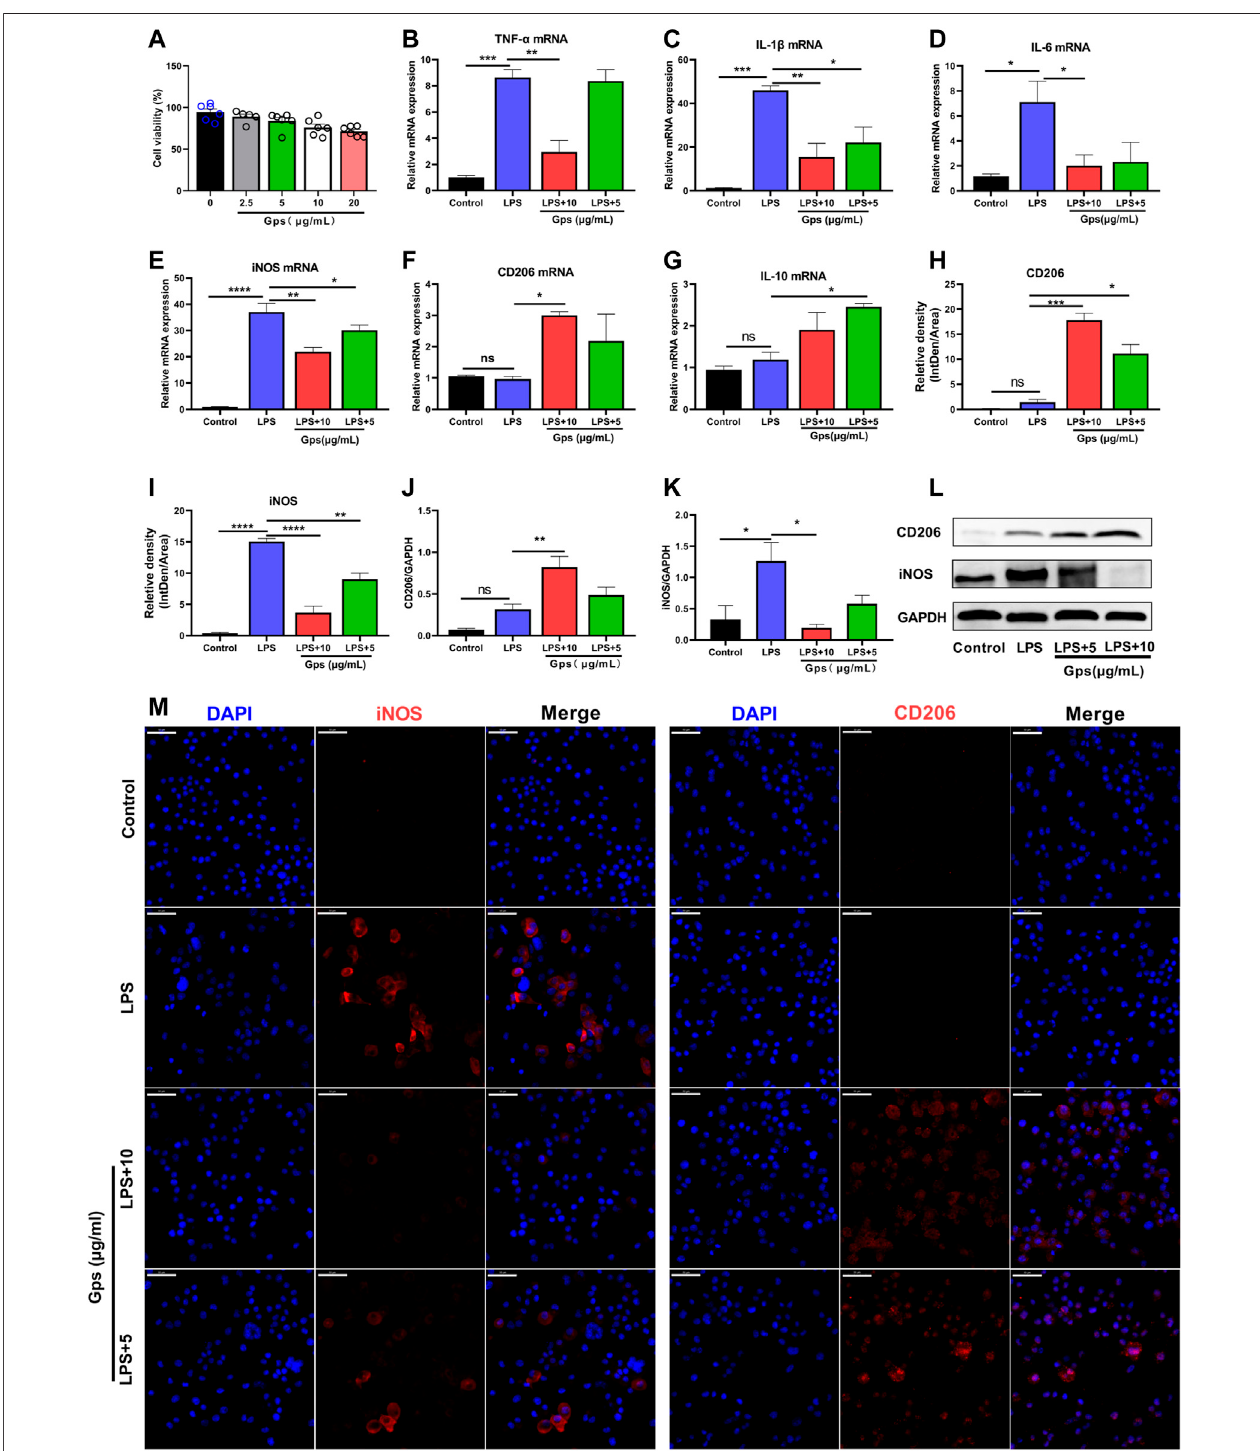
FIGURE2| GpsregulatesmicroglialcelllinestatetransitioninLPS-exposedBV-2cells. (A) BV-2cells(1×10 5 cells/well)wereseededin96-wellcultureplates,and exposed to Gps at concentrations of 0, 2.5, 5, 10, and 20 μ g/ml. After 48 h, cell viability was assessed using a CCK-8 assay. The OD450 values of cell viability were shown on they-axis. n =6 foreach groups from 2sets of experiments. (B – G) The expression ofTNF-03B1, IL-1 β , IL-6, iNOS, CD206, and IL-10 mRNA, respectively, in control(untreated),LPS(50 μ g/ml),andLPS(50 μ g/ml)andGps(10 μ g/mland5 μ g/ml,respectively)BV-2cellsweredeterminedusingqPCR.N=3fromtriplicate culture for each group. (H,I) The relative fl uorescence intensity ofiNOS and CD206 in the different groups of BV-2 cells. Thevalues areexpressed byIntDen/Area on the